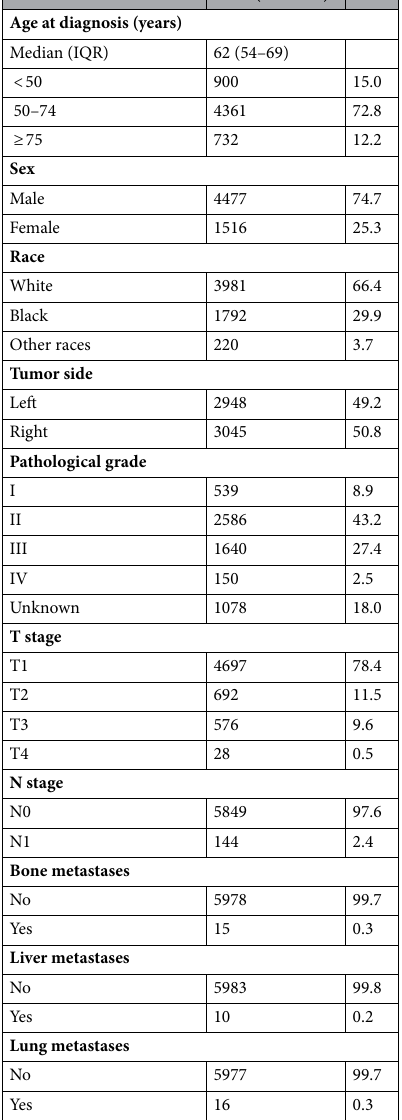
Table 1. Baseline characteristics of patients with papillary renal cell carcinoma. IQR interquartile